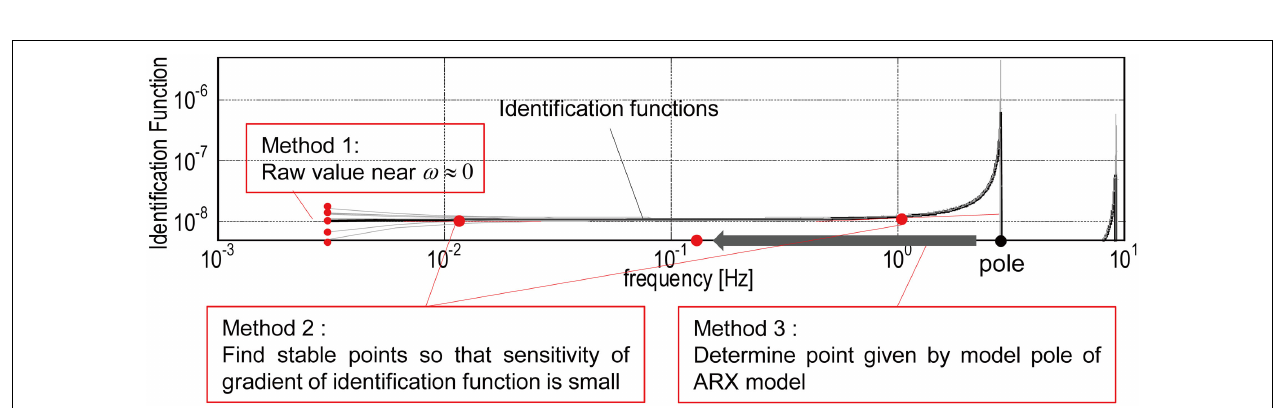
FIGURE 11 | Cumulative frequency of identified story stiffnesses .